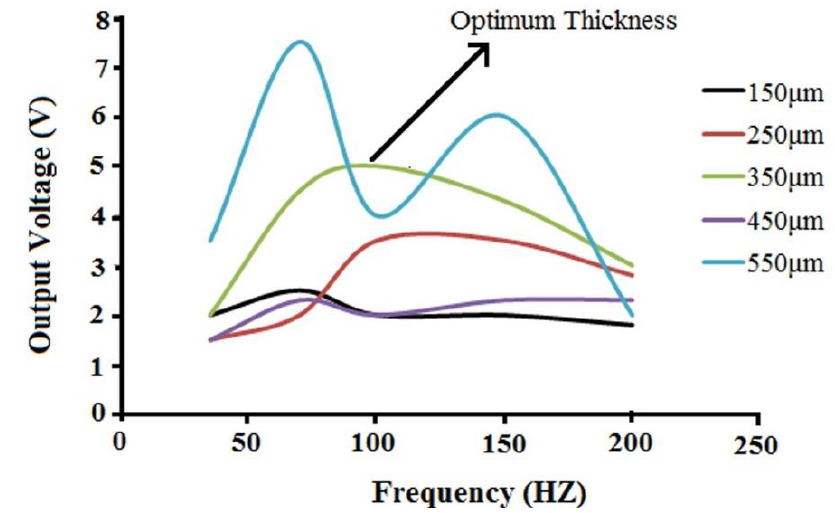
Figure 7. Effect of frequency on the voltage output for various electrospun PVDF/LiCl web Figure 7. E ff ect of frequency on the voltage output for various electrospun PVDF / LiCl web thicknesses.